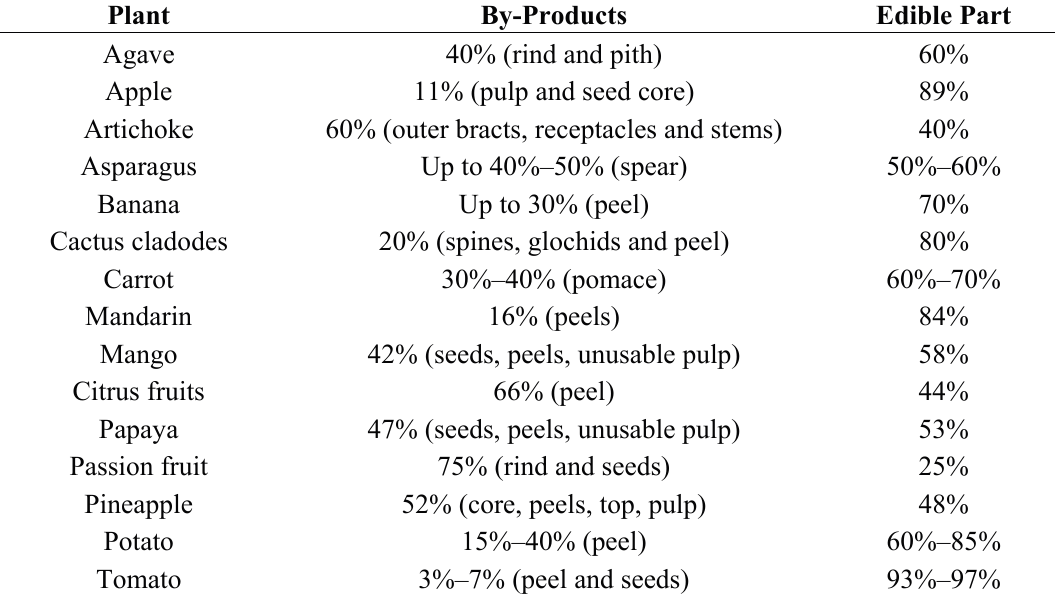
Table 1. By-product quantities generated from some fruit and vegetable processing industries [7]. Plant By-Products Edible